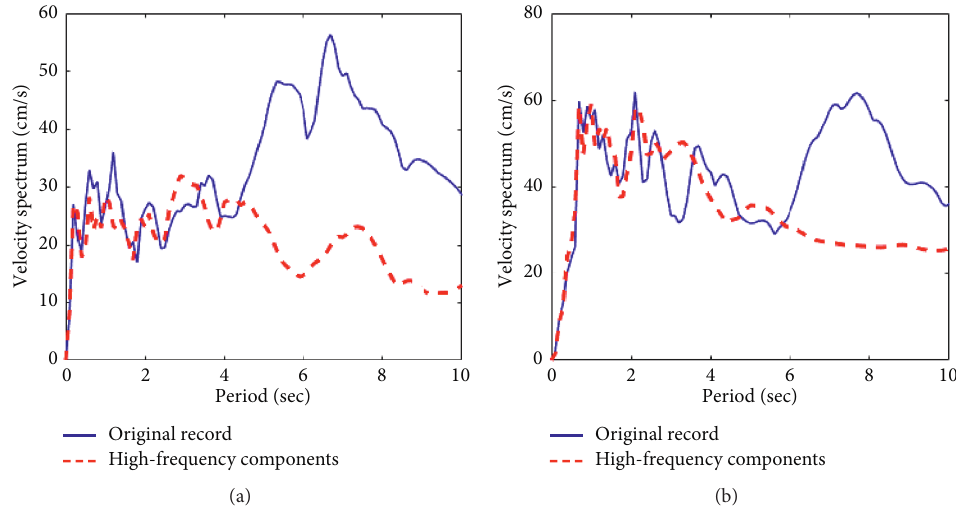
Figure 19: Comparison of original records with the simulations in terms of velocity spectrum. (a) CHB002EW and (b)